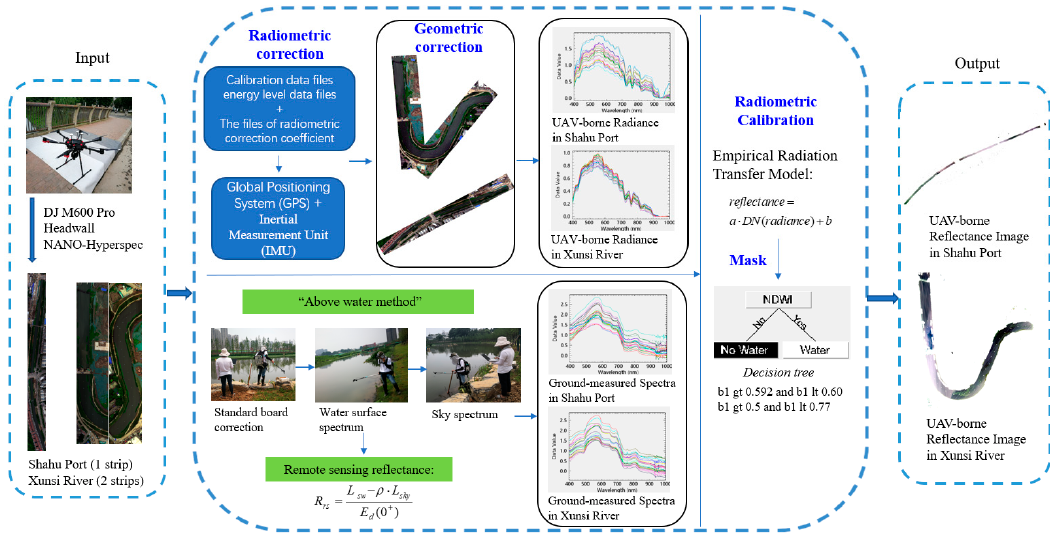
Figure 4. Preprocessing of the UAV-borne HRS images.